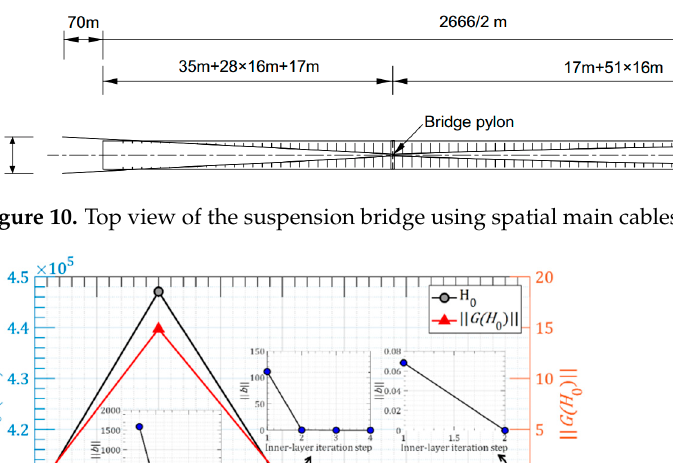
Figure 12. The main cable shape from the initial coordinates to the target configuration for 3D spa- tial main cables: ( a ) y -direction; ( b ) z -direction.